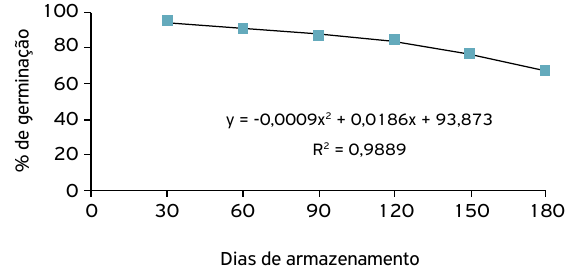
Figura 4. Porcentagem de germinação de conídios de B. bassiana em mistura granulada acondicionada em embalagem de polietileno armazenada em refrigerador (temperatura 6 ± 2°C) durante 180 dias.